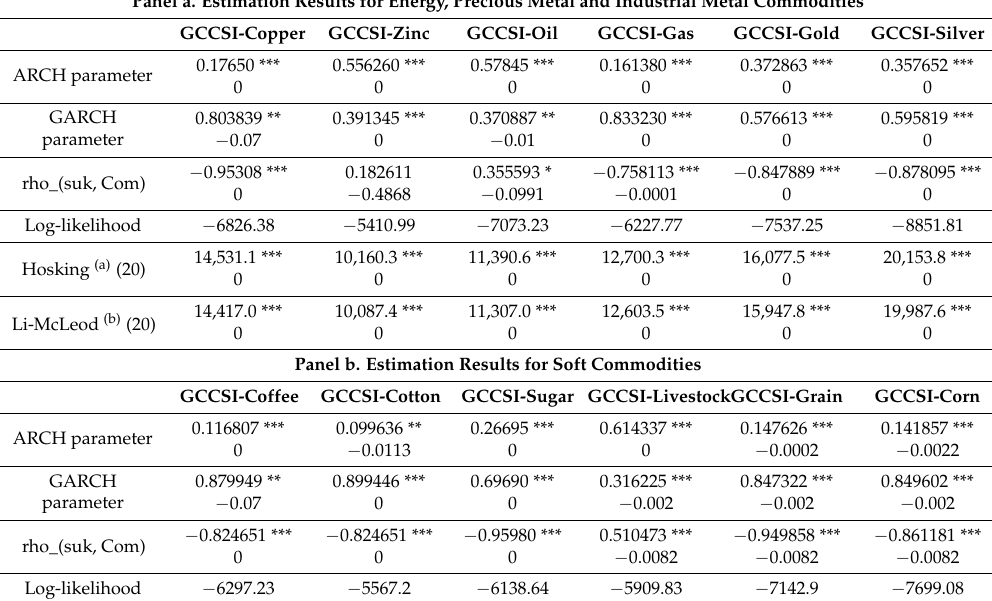
Table 3. The multivariate DCC-GARCH model estimating results. Panel a. Estimation Results for Energy, Precious Metal and Industrial Metal Commodities